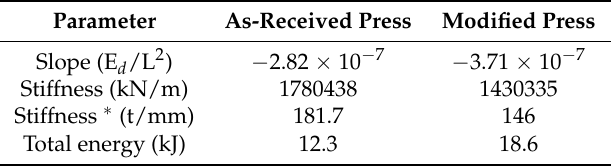
Figure 7. Adjustment of the stiffness for the conventional and the modified presses. Table 5. Estimation of the frame stiffness for both screw presses.